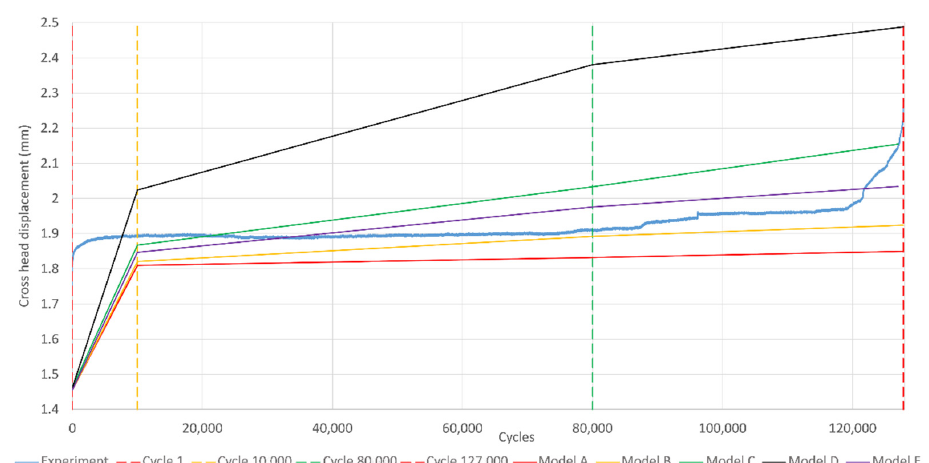
Figure 27. The displacement differential from the experiment and test compared.